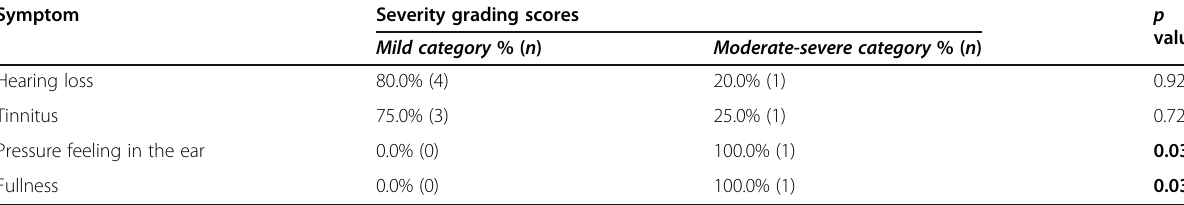
Table 2 Symptoms accompanying dizziness in CCHF patients Symptom Severity grading